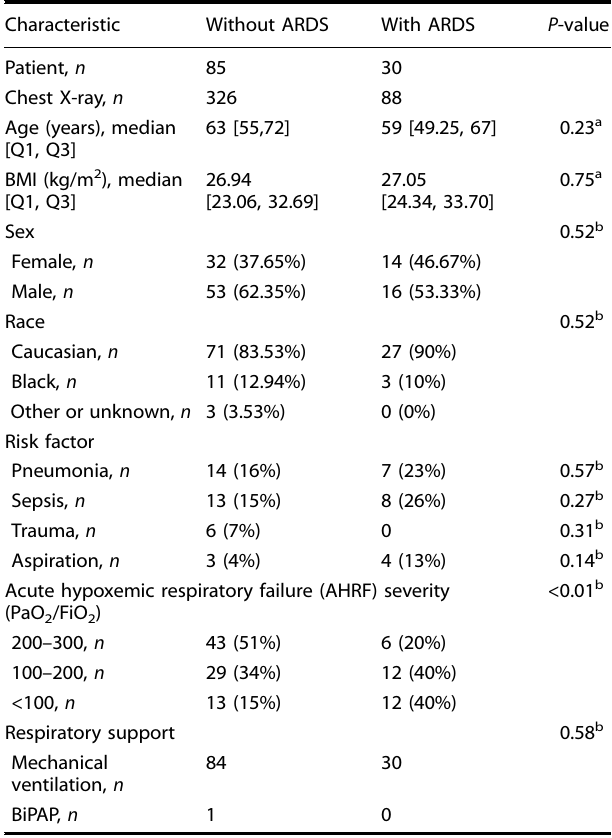
Table 1. Demographics of study patients.